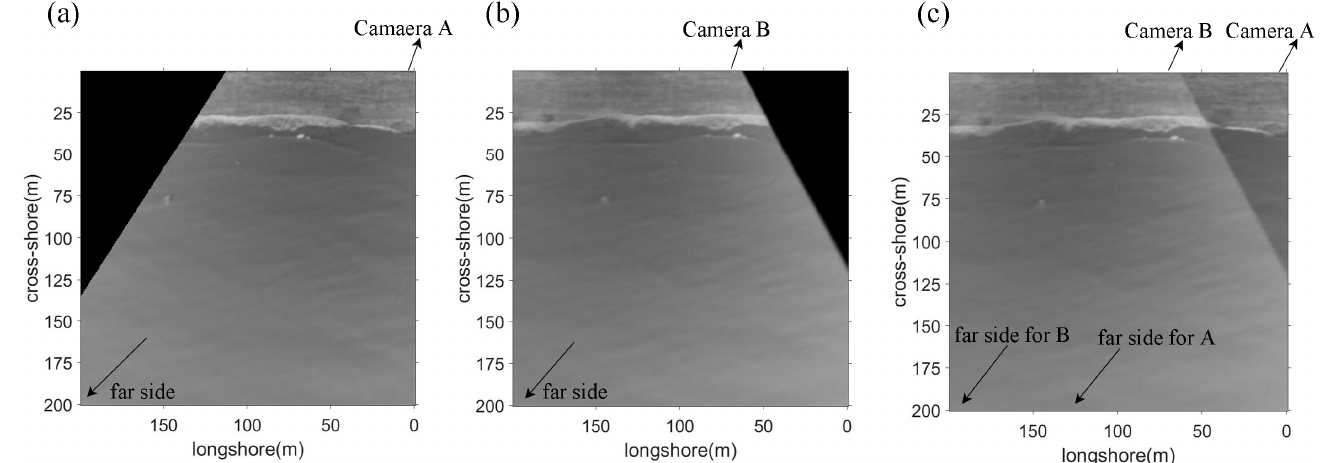
Figure 21. The far-side swell waves affect the results error of camera A alone, whereas camera B compensate for the rectification bias of camera A. ( a ) Orthoimage of camera A. ( b ) Orthoimage of camera B. ( c ) Orthoimage of panoramic image.